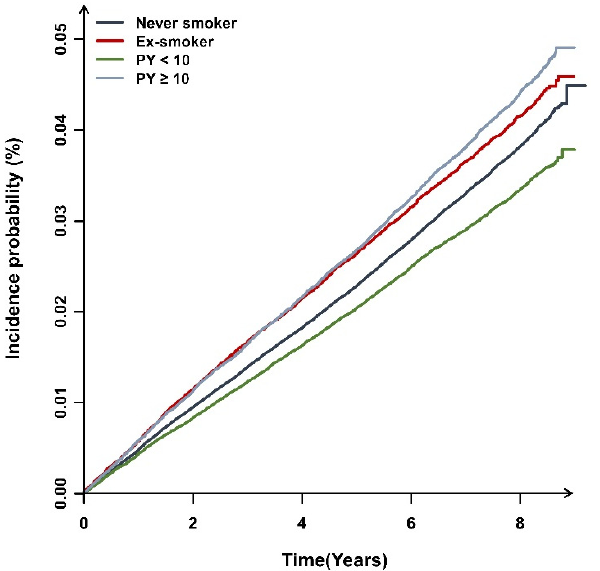
Figure 2. Cumulative incidence of bronchiectasis according to smoking status. Abbreviation: PY, pack-years. Table 2. Association of smoking status with the incidence of bronchiectasis.